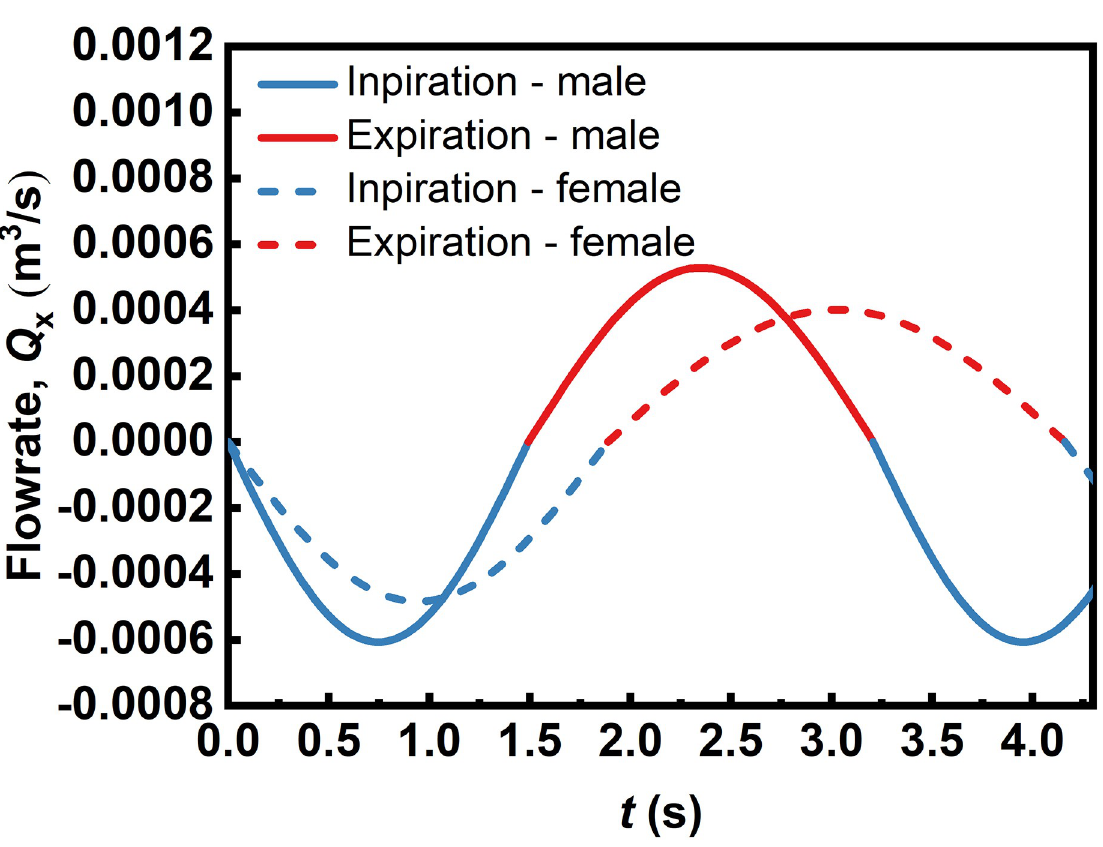
Fig 4. Representative inspiration/exhalation flowrate vs. time curves for a representative adult male and female obtained using the model in the respiration model section. The coefficients that describe these curves as per Eq 1, namely α in , β in , α out , and β out , are 0.61, 2.10, 0.53, 1.83 for males and 0.48, 1.66, 0.40, 1.38 for females, respectively.